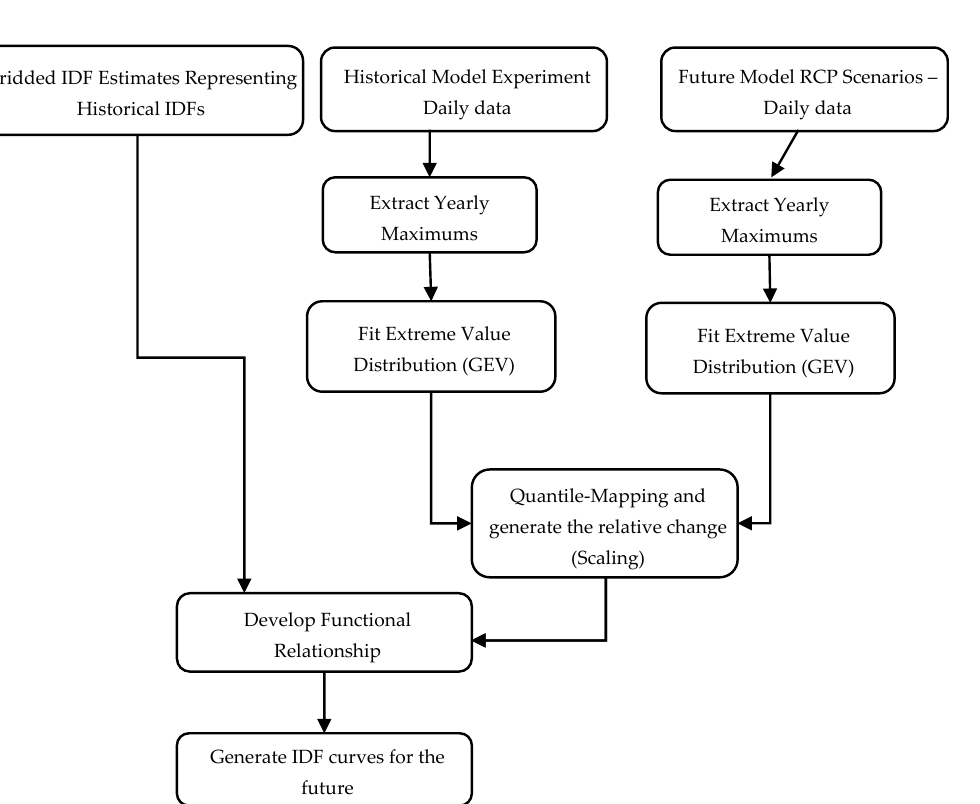
Figure 2. Modified Equidistance Quantile-Matching method for generating future IDF curves under climate change for gridded data.